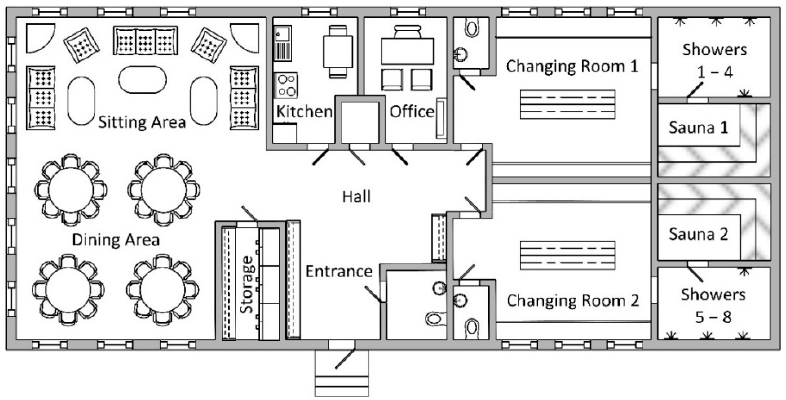
Figure 2. Side and front elevations of the clubhouse building.